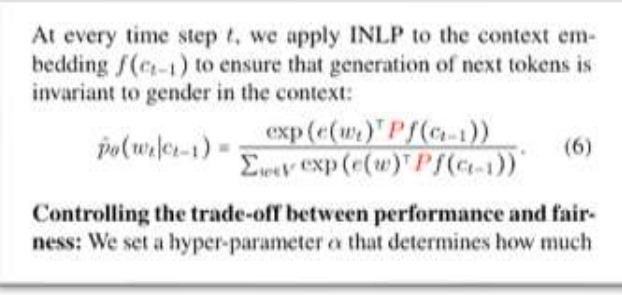
Figure 1. Screengrab from Liang, “Towards Understanding,” 5, showing the quantification of language as tokens that can be processed by an